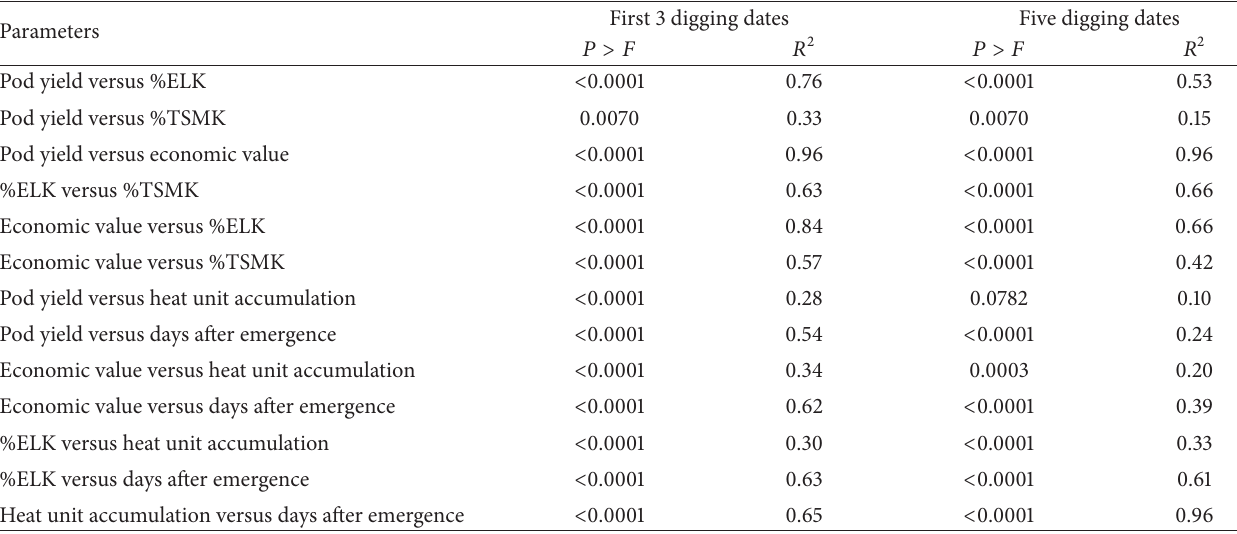
Table 1: Pearson correlations for canopy defoliation, pod yield, percentages of extra large kernels (%ELK) and total sound mature kernels (%TSMK), economic value, days after peanut emergence, and heat unit accumulation in the experiment for the cultivar Gregory with the first 3 of 5 digging dates or with all 5 digging dates included. Data are pooled over 17 experiments from 2003 to